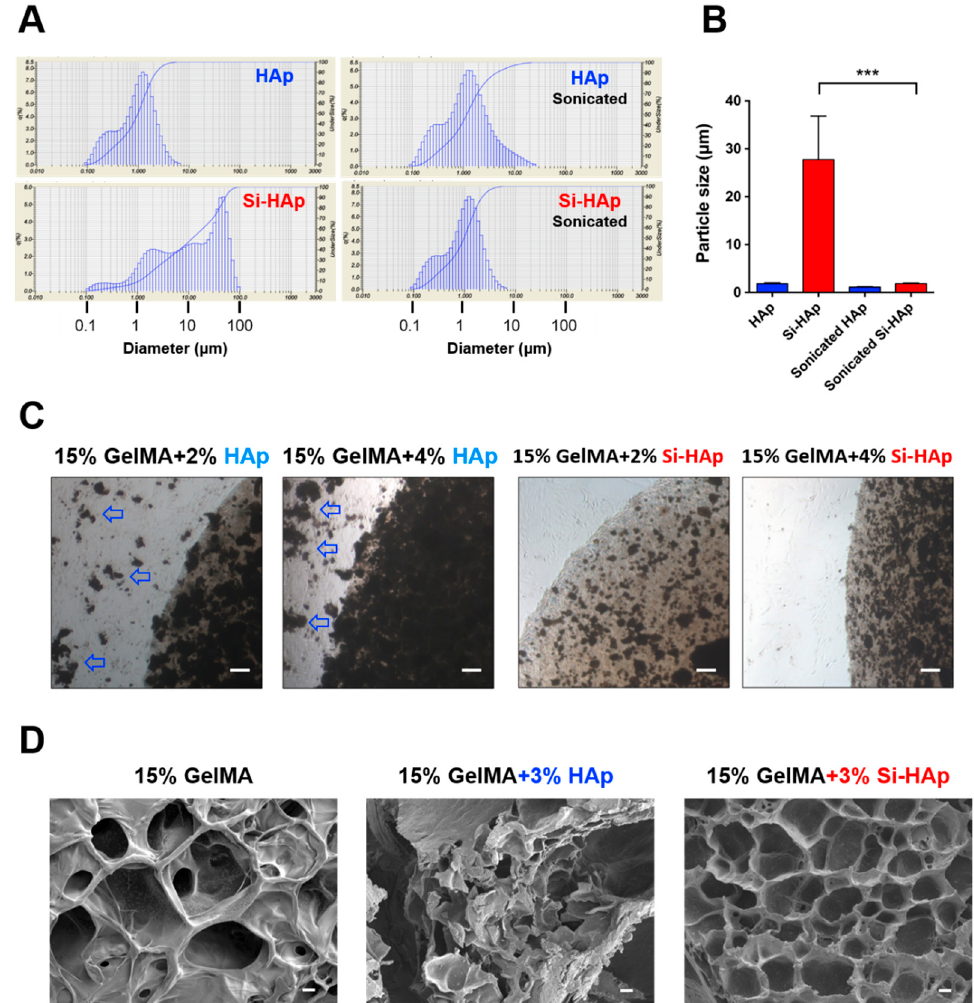
Figure 2. Size of nanoparticle agglomerates and dispersion of hydroxyapatite (HAp) and silanized HAp (Si-HAp) in the gelatin methacrylate (GelMA) solution and composite hydrogels. ( A ) Particle size analysis of HAp particles in the GelMA solution. Left panel: before sonication, Right panel: after sonication. ( B ) Quantification of particle size of HAp and Si-HAp with and without ultrasound sonication. mean ± SD µm. *** p < 0.01. ( C ) MG63 cell-embedded composite gels after 24 h incubation. Arrows indicate the debris of unpolymerized GelMA composite gels. Scale bar, 100 µm. ( D ) Scanning electron microscopy images of 15% GelMA, 15% GelMA with 3% HAp and 15% GelMA with 3% Si-HAp composite hydrogels. magnitude, 1000×. Scale bar, 1 µm.